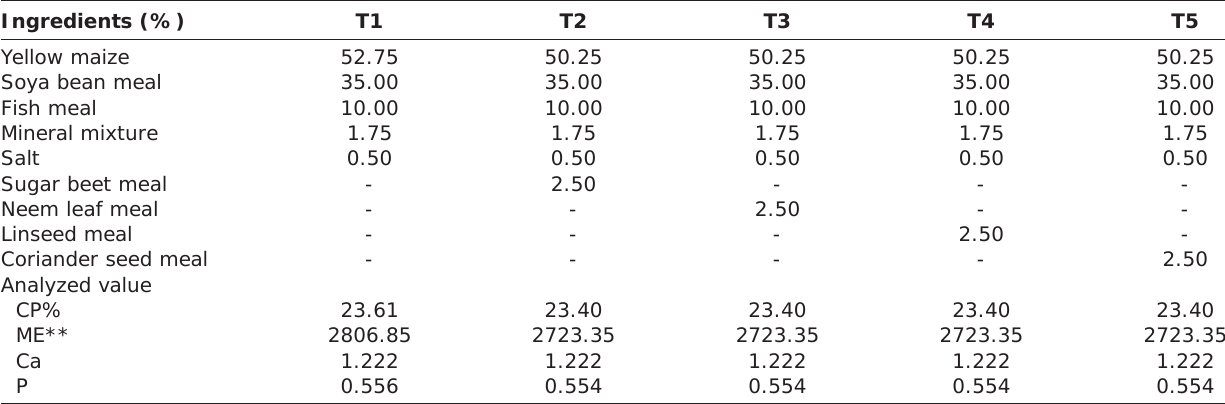
Figure-1: Effect of dietary supplements on average feed intake(g)/bird at weekly interval and 6 th week in Table-3: Percentage composition of experimental diet for starter.